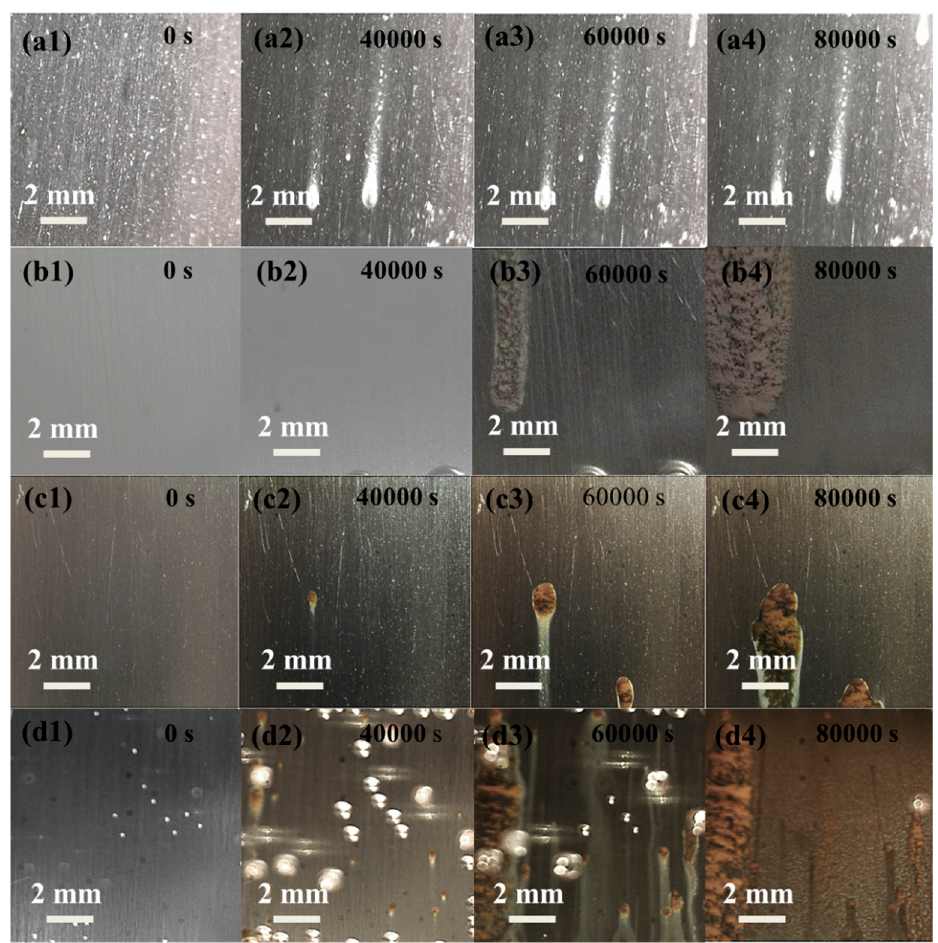
Figure 3. Surface morphologies from in-situ monitoring of the propagation of pitting corrosion of carbon steel with an optical microscope in the solutions with different concentrations of chloride ions: ( a1 ), ( a2 ), ( a3 ), ( a4 ) 500 mg/L NaCl, ( b1 ), ( b2 ), ( b3 ), ( b4 ) 800 mg/L NaCl, ( c1 ), ( c2 ), ( c3 ), ( c4 ) 1000 mg/L NaCl, ( d1 ), ( d2 ), ( d3 ), ( d4 ) 1200 mg/L NaCl.